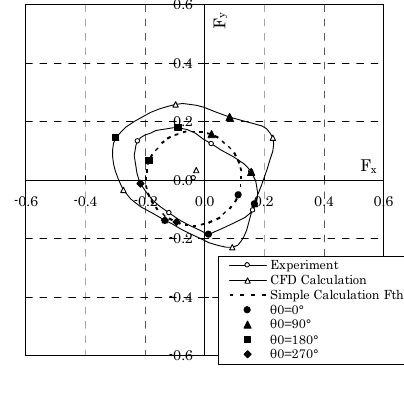
Fig. 14 Lissajous figures of force ( φ =0.019) Fig. 15 Lissajous figures of force from pressure